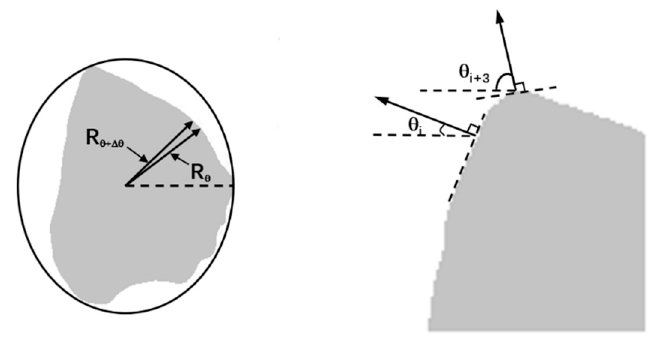
Figure 5. Illustration of form2D and angularity.